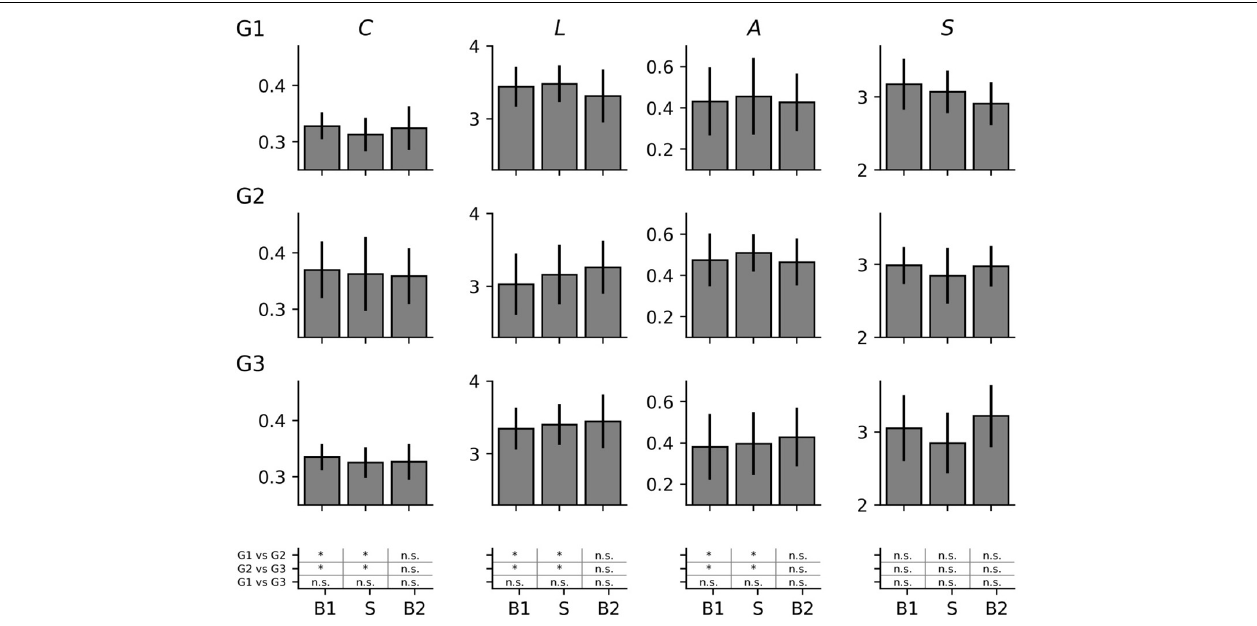
FIGURE 1 | Global network characteristics (average clustering coefficient C , average shortest path length L , synchronisability S , and assortativity A ) of the investigated groups (G1 = focal epilepsy group, G2 = generalized epilepsy group, G3 = non-epilepsy group) in the three phases of the study (B1 = pre-stimulation baseline 1, S = stimulation, B2 = post-stimulation baseline 2). Mean values and standard deviation. *significant (Mann-Whitney U -test, p < 0.05), n.s. =